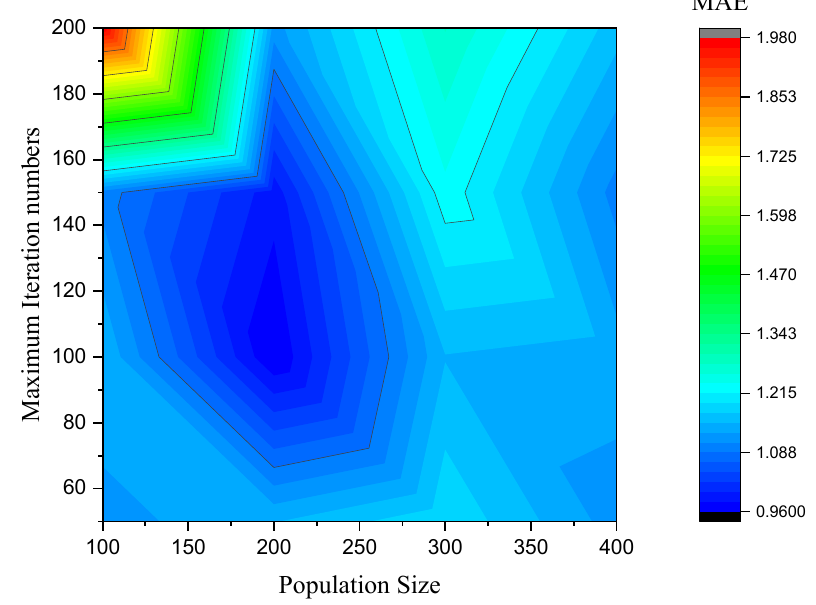
Figure 2. Values of the objective function for different values of parameters.